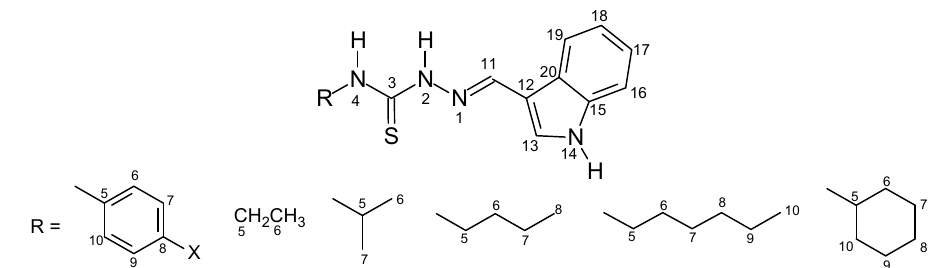
Figure 2. Indole carboxaldehyde series 16–24